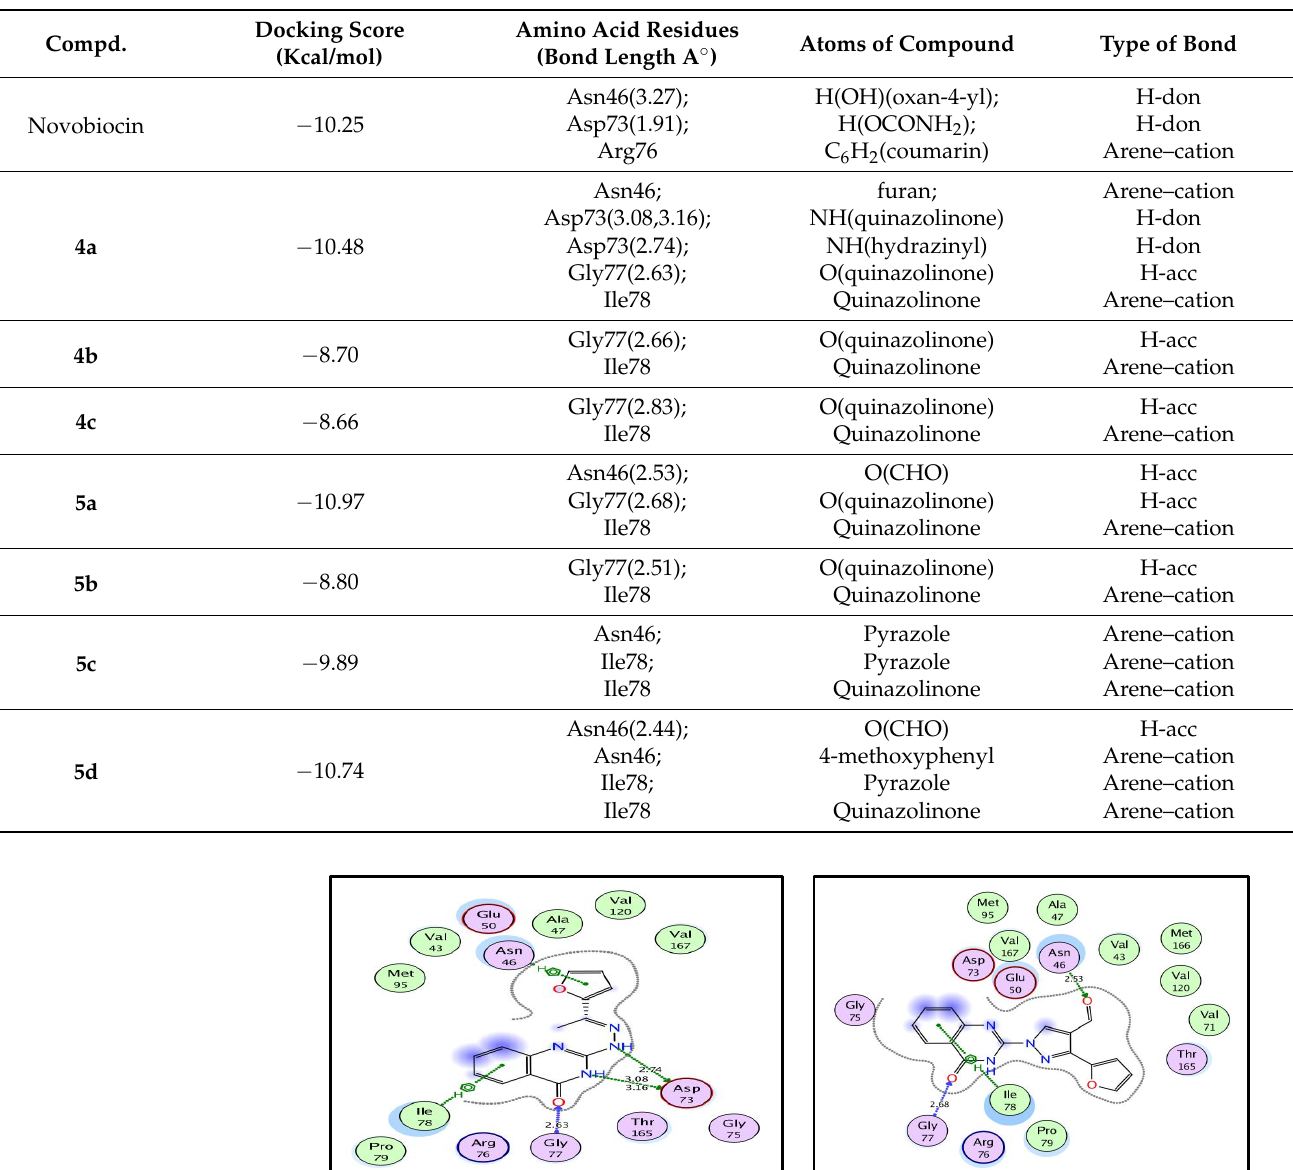
Table 4. Molecular docking results of the most active quinazolin-4(3 H )one derivatives with E. coli DNA gyrase.